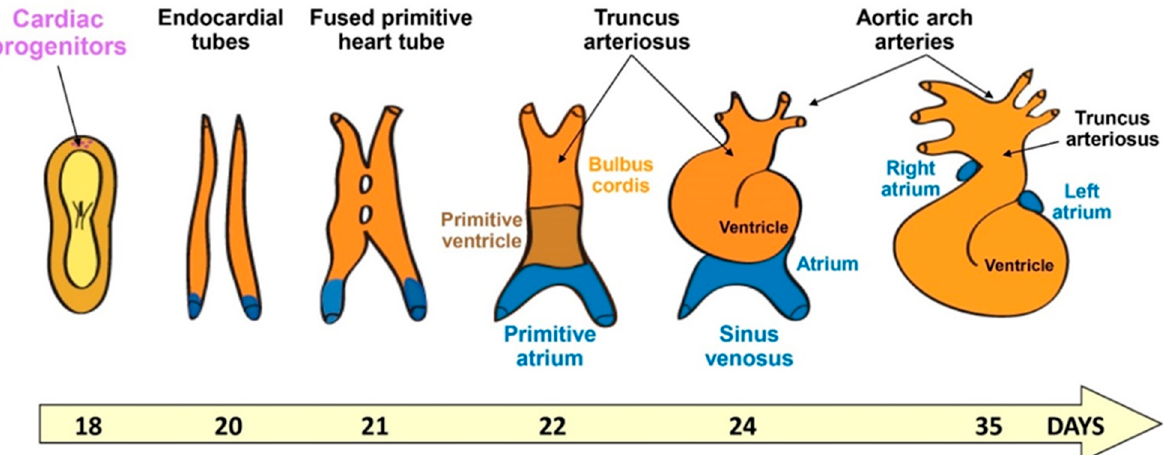
Figure 1. Cartoon illustrating human cardiac developmental stages from gastrulation.